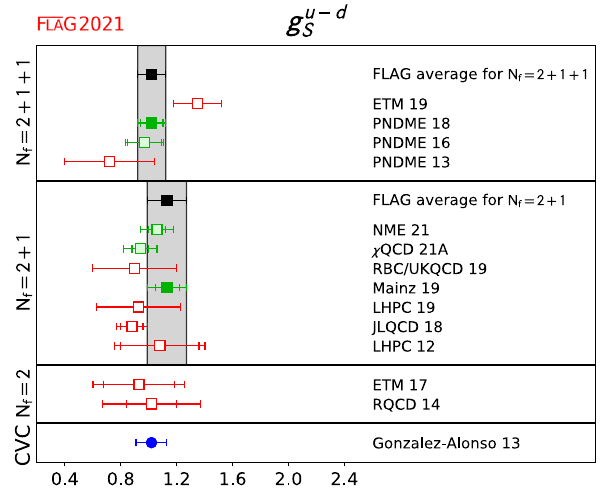
Fig. 44 Lattice results and FLAG averages for the isovector scalar charge g u − d